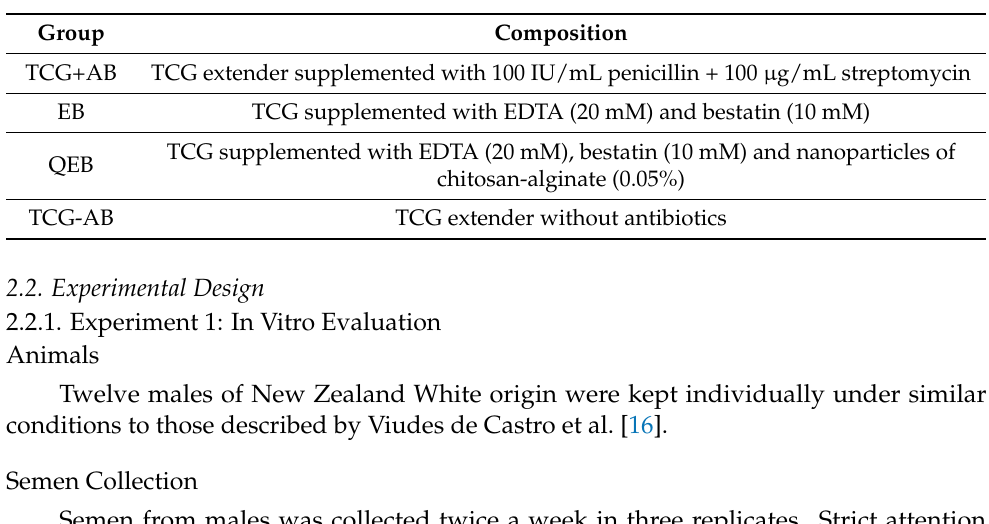
Table 1. Semen extenders